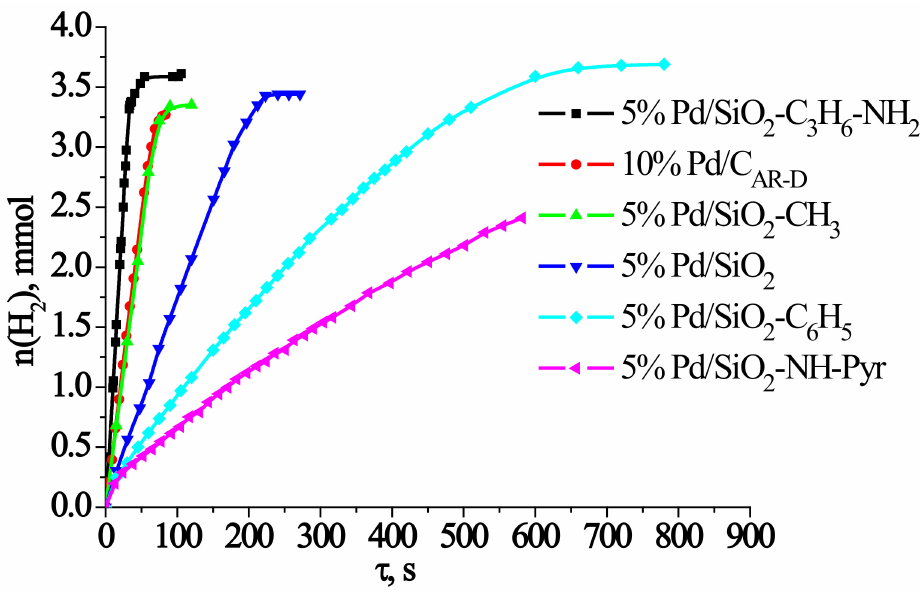
Figure 7. Kinetic curves of hydrogen uptake in the hydrogenation of p-nitroaniline in an aqueous solution of 2-propanol-water. T = 298 K, m (cat) = 0.3 ± 0.05 g, m (NA) = 0.5 ± 0.05